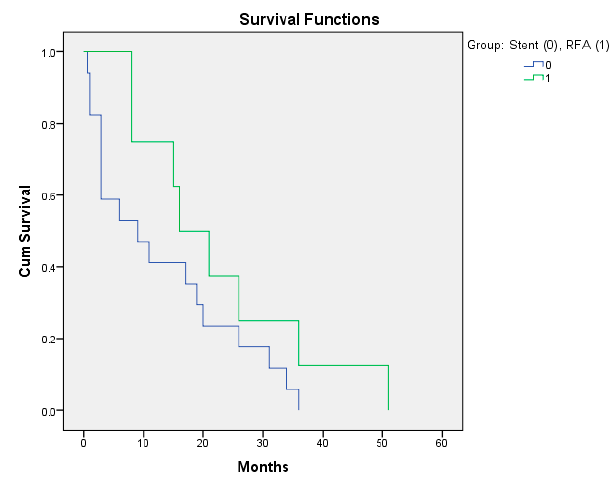
Figure 3. Patients for which the RFA adjuvant method was applied had an increased survival period. Table 2. Variability of the minimal and maximal bilirubin levels between groups.